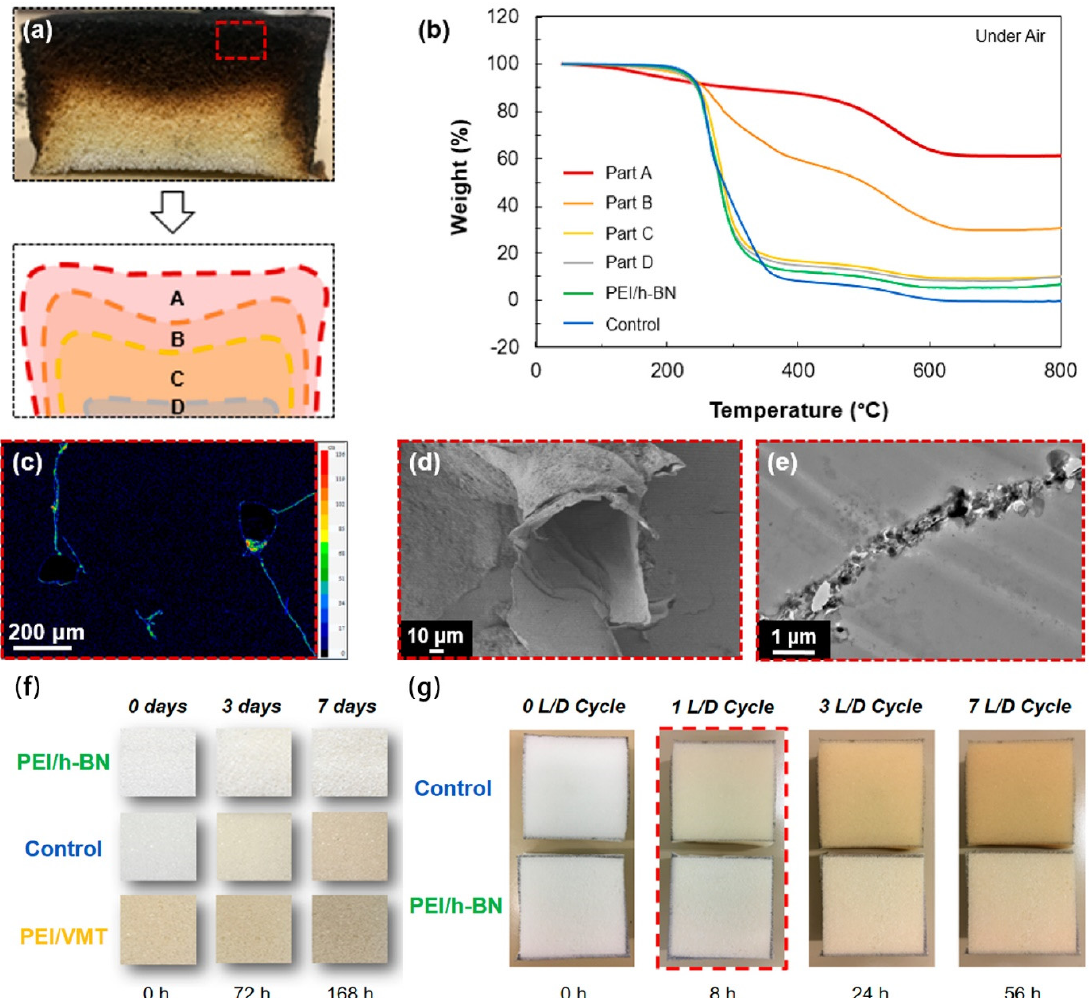
Figure 5. Hexagonal boron nitride nanosheet flame − retardant coating. ( a ) Cross − sectional image of the PEI/h − BN − coated PUF after torch testing with the positions of the four parts (A − D) of the residue studied by ( b ) thermogravimetric analysis compared to uncoated and PEI/h − BN unburnt coated PUF. ( c ) EPMA B X − ray mapping, ( d ) SEM image, and ( e ) TEM cross − sectional micrograph of the charred portion of PEI/h − BN − coated PUF after torch testing. Aging results from ( f ) the natural environment and ( g ) under UV light. Reprinted with permission from Ref. [61] Copyright 2019 American Chemical Society.